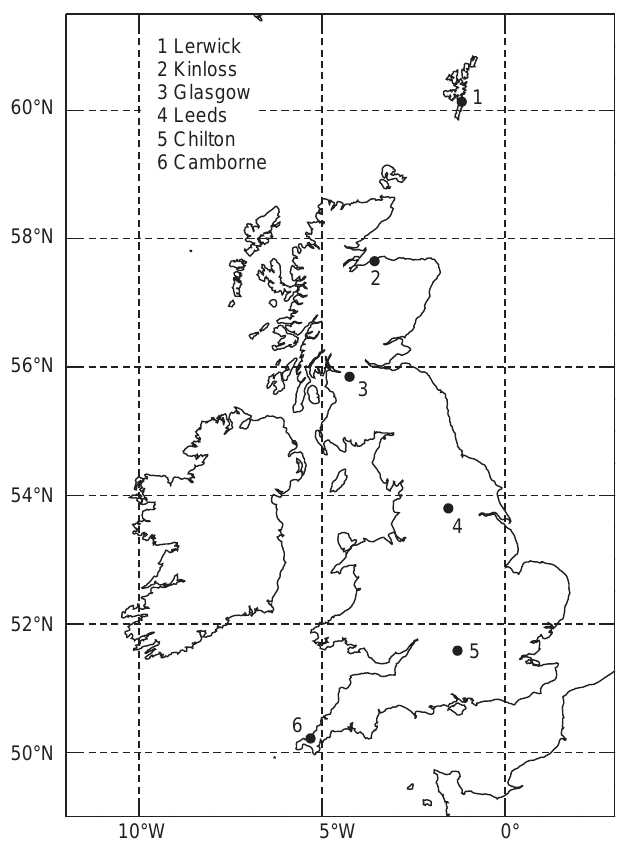
Fig. 1. Map of the UK and Ireland showing the positions of the 6 UV monitoring stations. In addition ozone measurements are made at Camborne ( station 6 ) and Lerwick ( station